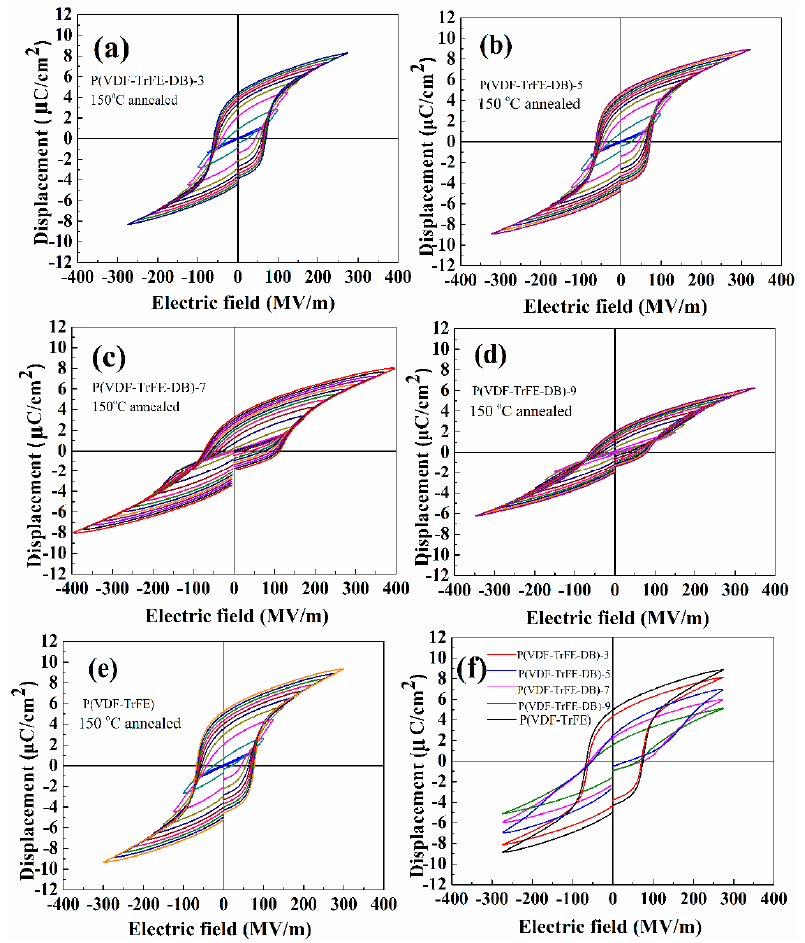
Figure 10. Bipolar D–E loops of P(VDF-TrFE-DB)s with different composition and